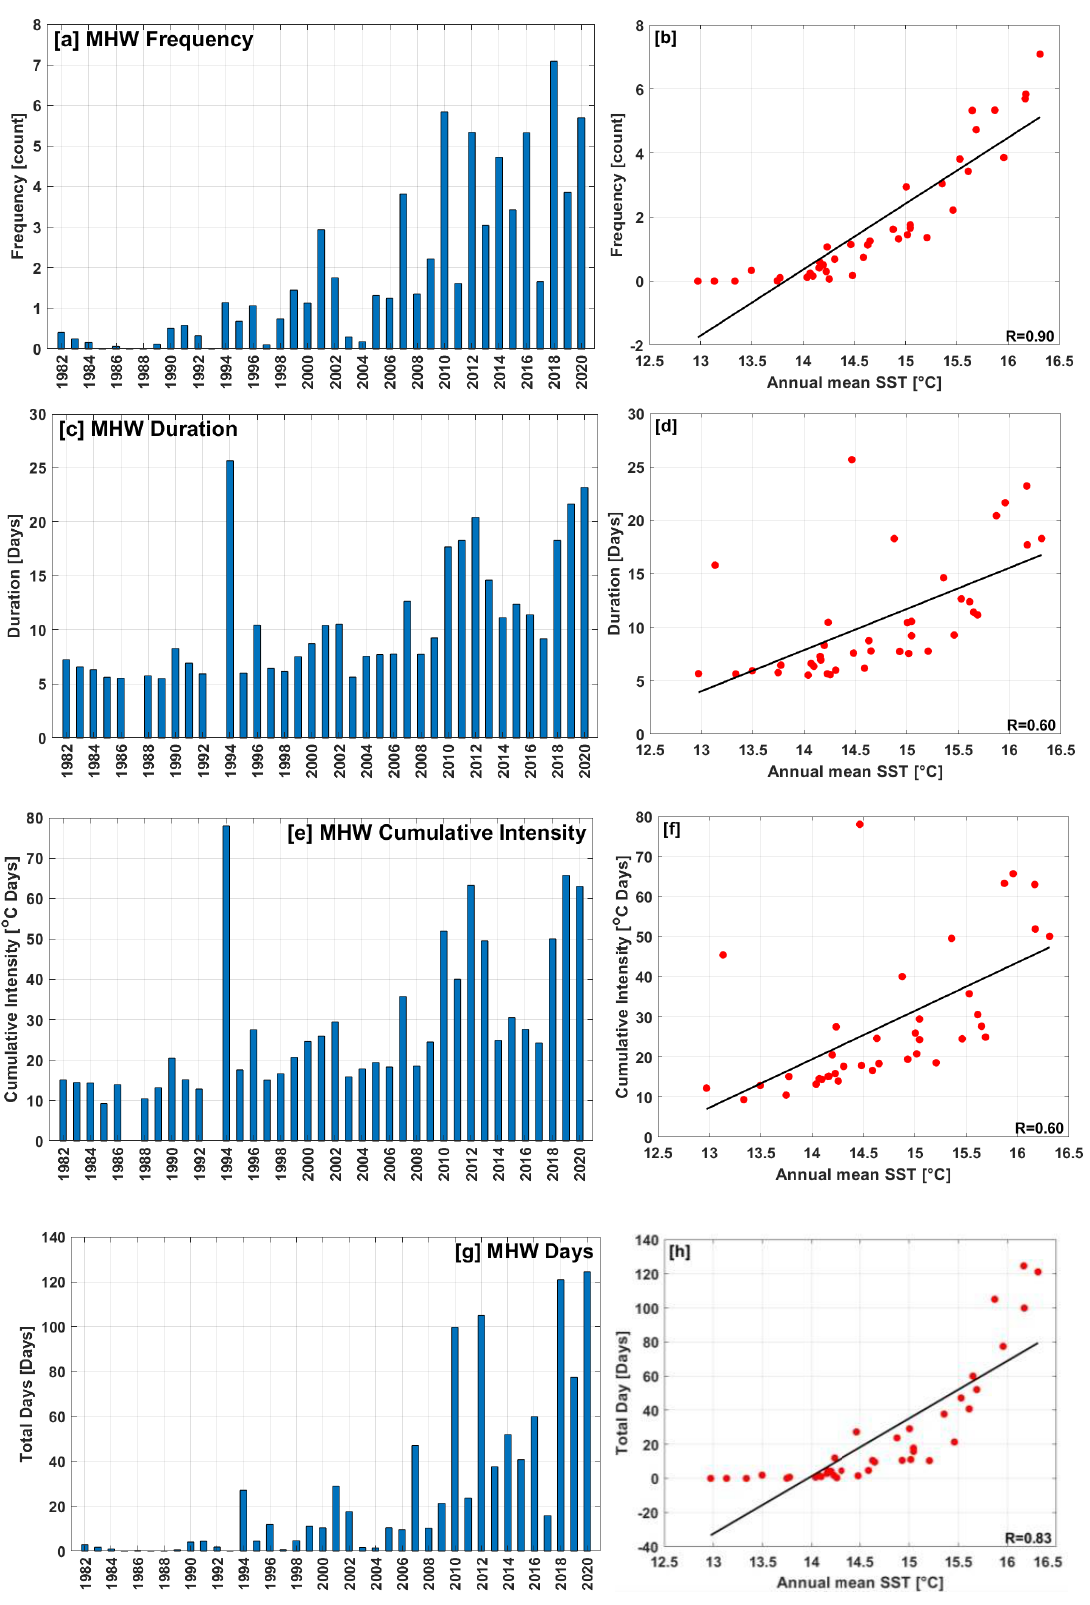
Figure 6. Regional averages of the annual mean ( a ) MHW frequency, ( c ) MHW duration, and ( e ) MHW cumulative intensity, ( g ) total MHW days. The scatter plots of the annual mean SST and ( b ) MHW frequency, ( d ) MHW duration, ( f ) MHW cumulative intensity, and ( h ) total MHW days over the Black Sea from 1982 to 2020, with the black lines representing the best-fit linear curve.